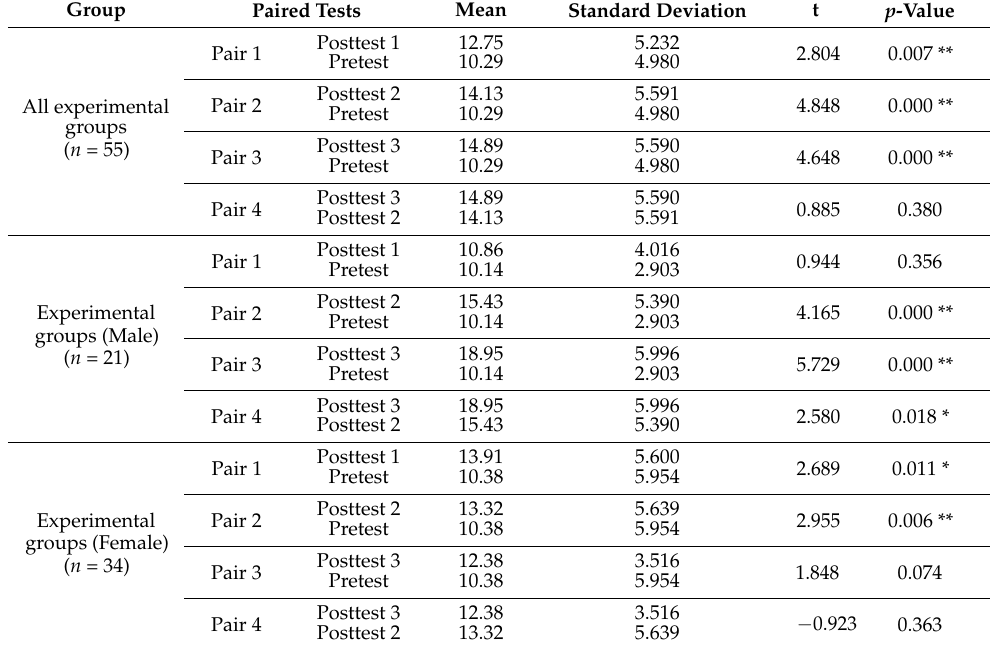
Table 4. Paired Samples t-test Results for the Differences between Paired Tests within the Experimen- tal